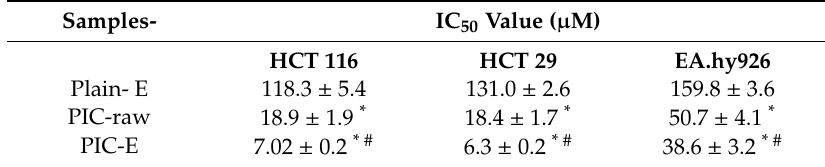
Table 6. Cytotoxicity of PIC-E in HCT 116, HCT 29, and EA.hy926 cells.